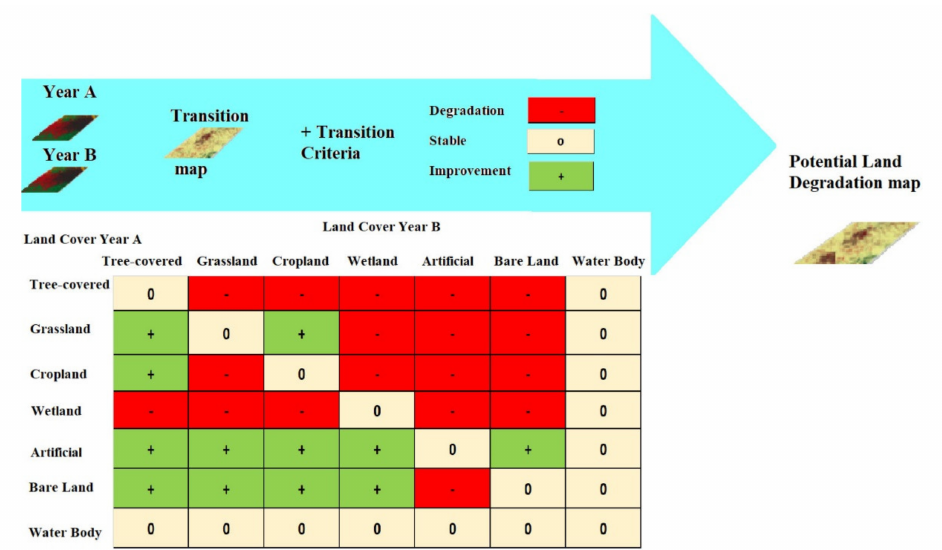
Figure 2. Potential land degradation map, using the land cover change relation to land degradation, according to the criteria